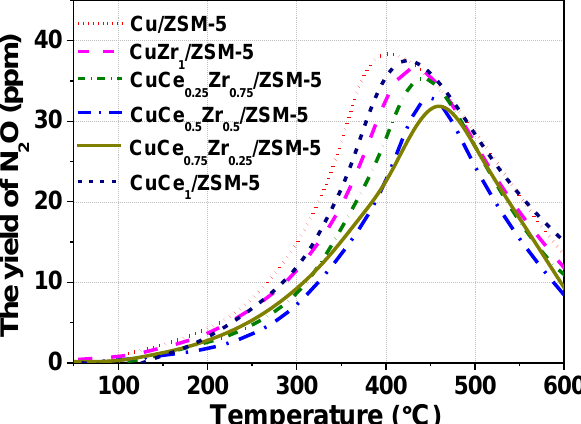
Figure 7. Yield of N 2 O during the selective catalytic reduction (SCR) process as a function of reaction temperature for Cu/ZSM-5 andCuCe x Zr 1 − x /ZSM-5 catalysts ( x = 0, 0.25, 0.5, 0.75 and 1).